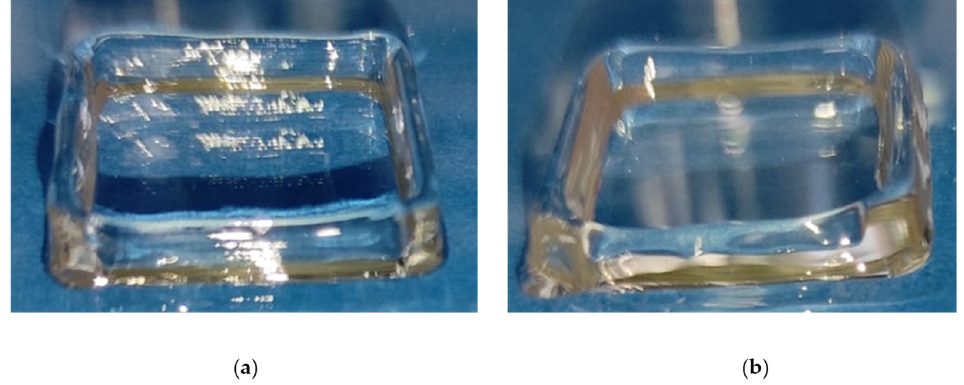
Figure 8. A 3D-printed square-shaped wall. The square side is 20 mm and is composed of 8 layers. ( a ) 36 °C; ( b ) 40 °C. ( a ) 36 ◦ C; ( b ) 40 ◦